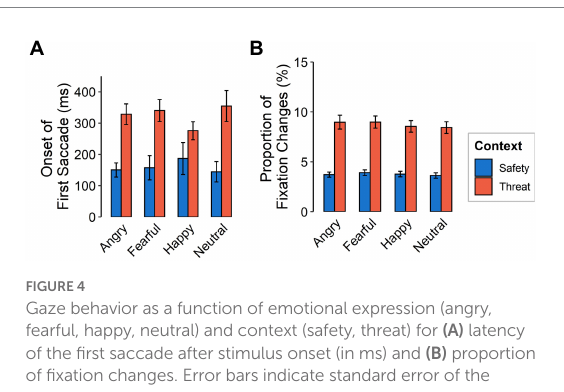
FIGURE 4 Gaze behavior as a function of emotional expression (angry, fearful, happy, neutral) and context (safety, threat) for (A) latency of the first saccade after stimulus onset (in ms) and (B) proportion of fixation changes. Error bars indicate standard error of the mean.